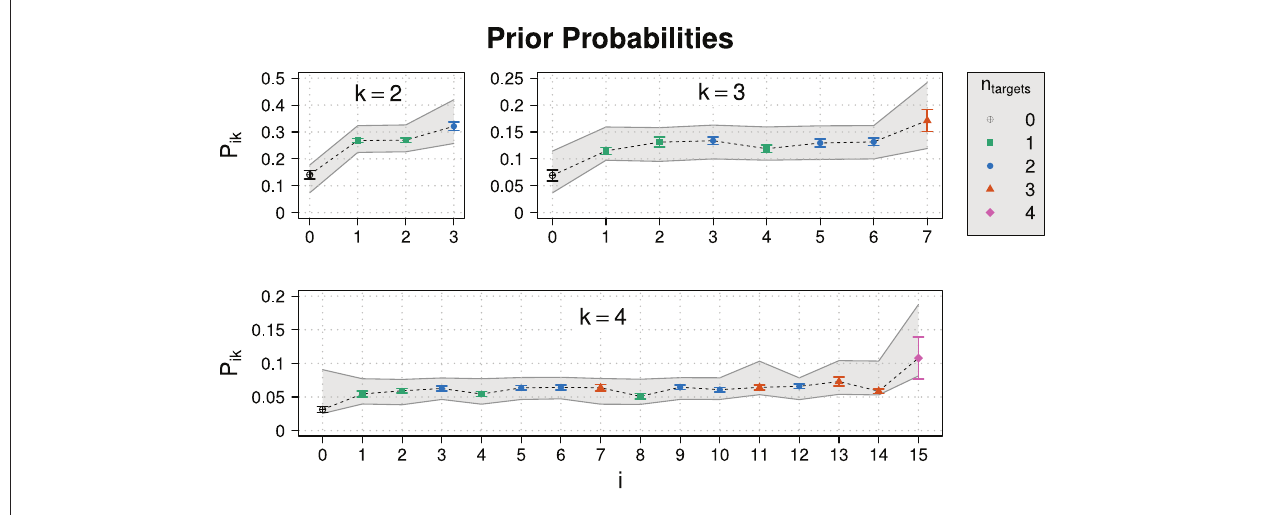
FIGURE 4 | Experimental results for the prior probability for normalized slider values P ik for different states i and domain sizes k in Experiment 1. Also shown are posterior predictive 95% HDIs (gray areas).